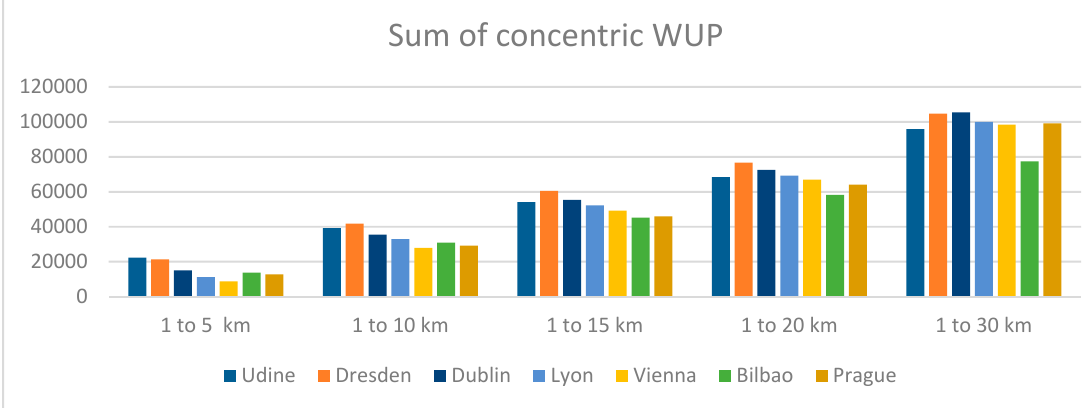
Figure 10. Sum of average WUP aggregated for concentric rings ranging from 1 to 5 km distance to 1 to 30 km distance and 1 to city’s edge. Cities are listed in order of sprawl based on the European Environment Agency and European Commission’s Joint Research Centre’s 2006 report.